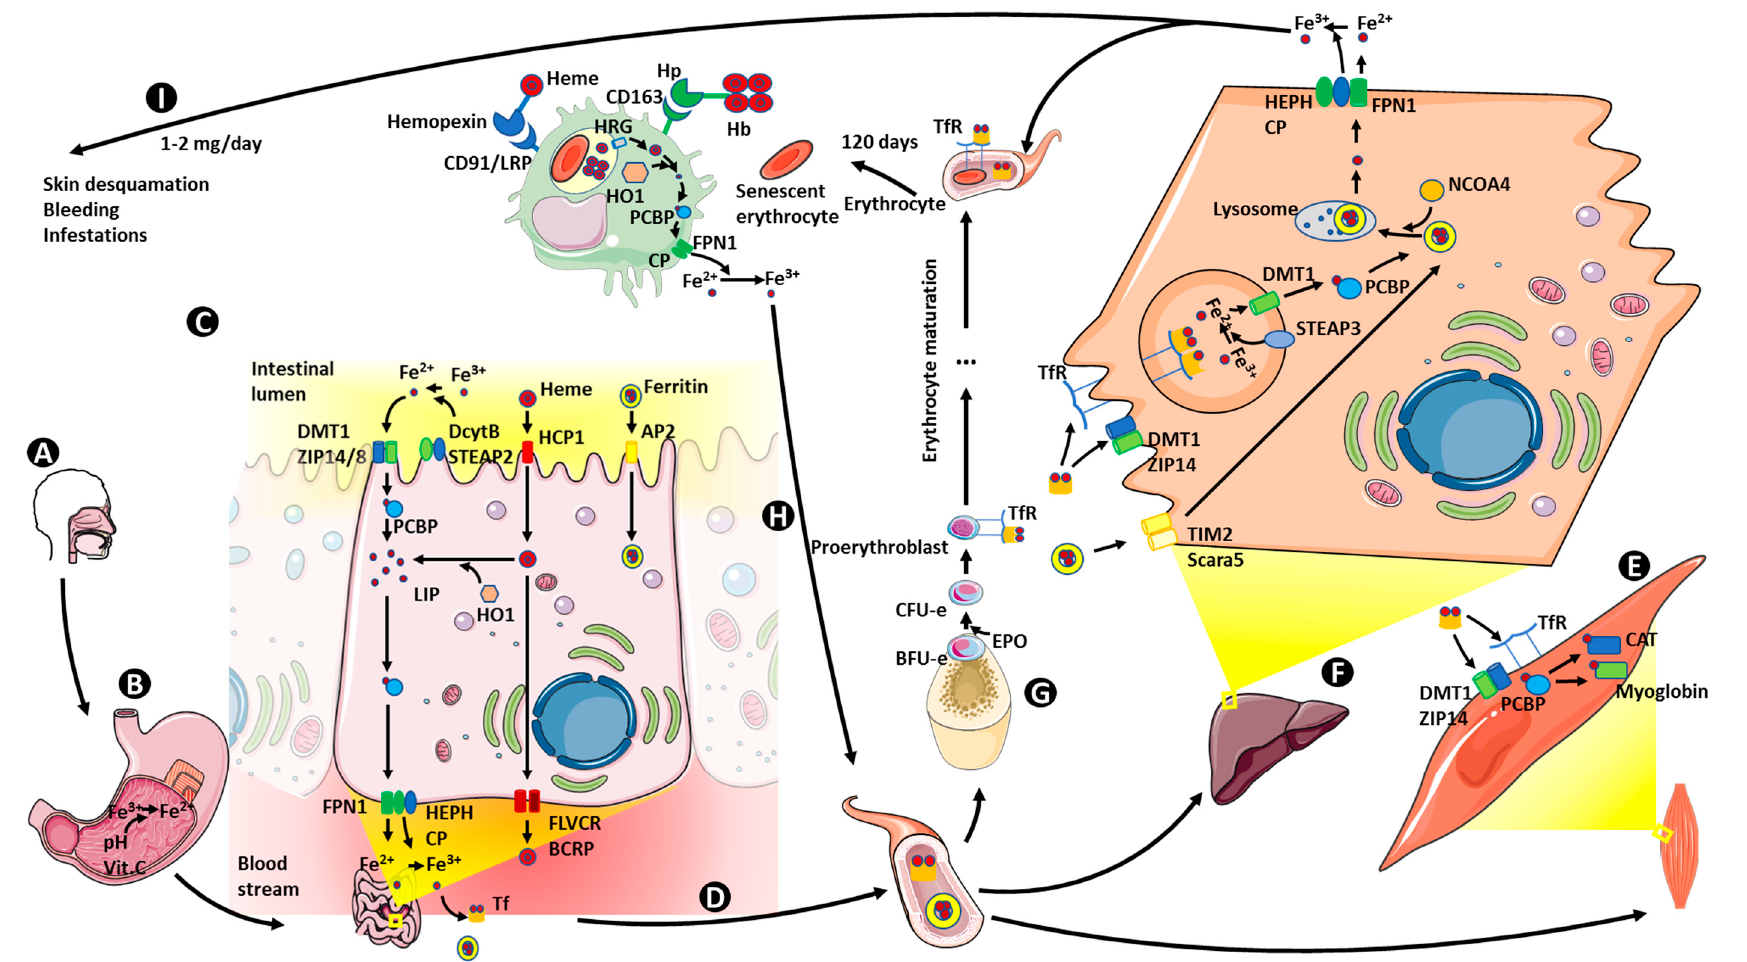
Figure 2. Physiology of Iron Metabolism. Iron ingested from the diet ( A ), is reduced from Fe 3+ to Fe 2+ in the stomach ( B ). In the duodenum, enterocytes transport Fe 2+ , heme groups and ferritin across the microvillus membrane ( C ). Fe 2+ is transported by ferroportin across the basolateral membrane into the portal system and must be oxidized to Fe 3+ for binding to transferrin and other molecules with high affinity for Fe 3+ to be transported to the liver. Transferrin-bound iron is necessary for cells expressing transferrin receptors for uptake of iron, mainly for production of heme proteins ( D ). Transferrin-bound iron is taken up by myocytes, where Fe 3+ is oxidized again to Fe 2+ in order to be incorporated into myoglobin ( E ), hepatocytes being the main ferritin store ( F ), and by proerythroblasts for synthesis